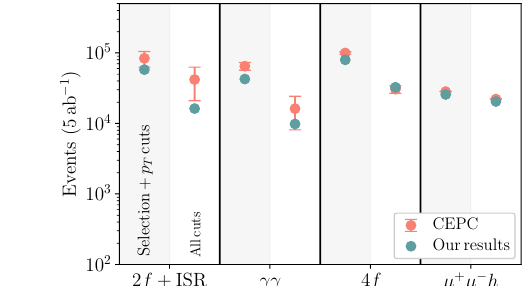
m reco 150 GeV, 80 GeV m (cid:22) + (cid:22) (cid:0) 100 GeV, (cid:20) (cid:20) (cid:20) (cid:20)